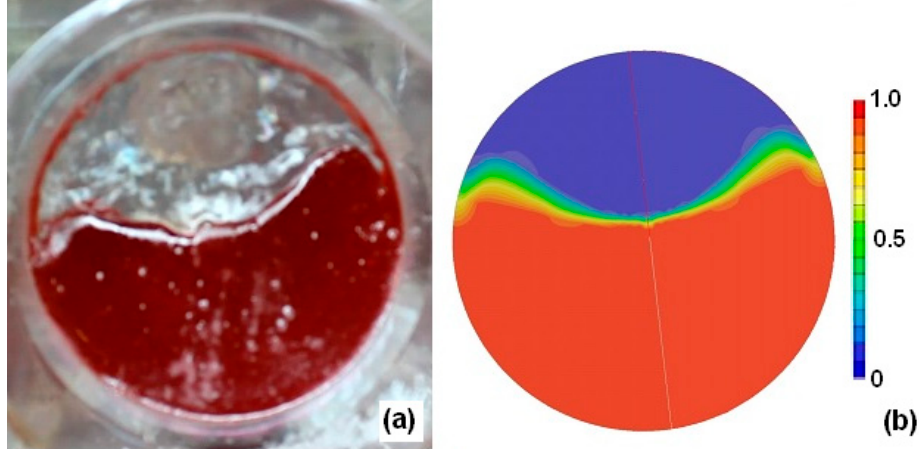
Figure 2. ( a ) Physical model with a scale factor of 1/17th to observe steel–slag behavior using water– engine oil respectively ( b ) Calculated ladle eye with mathematical